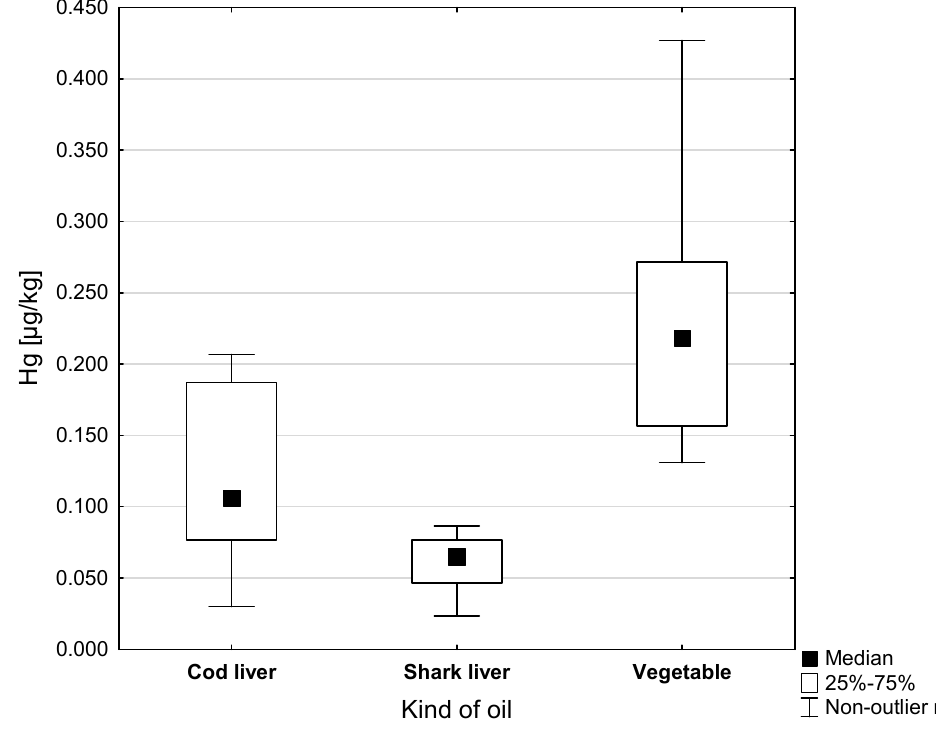
Figure 1. Hg concentrations in dietary supplements made of fish and vegetable oils (µg/kg).